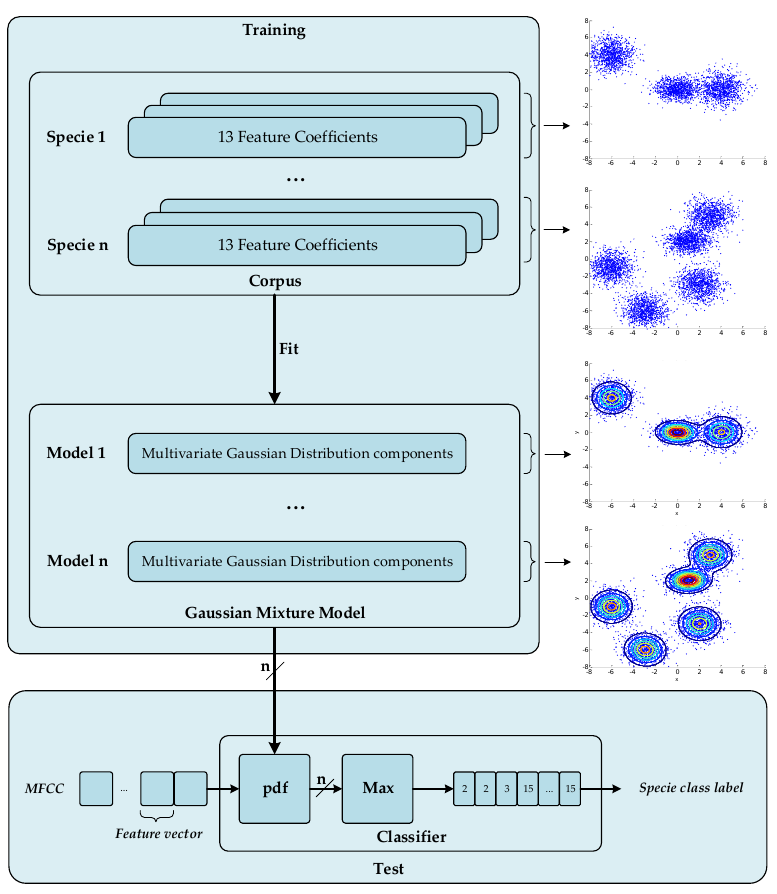
Figure 6. Training and test procedures of the proposed audio birdsong